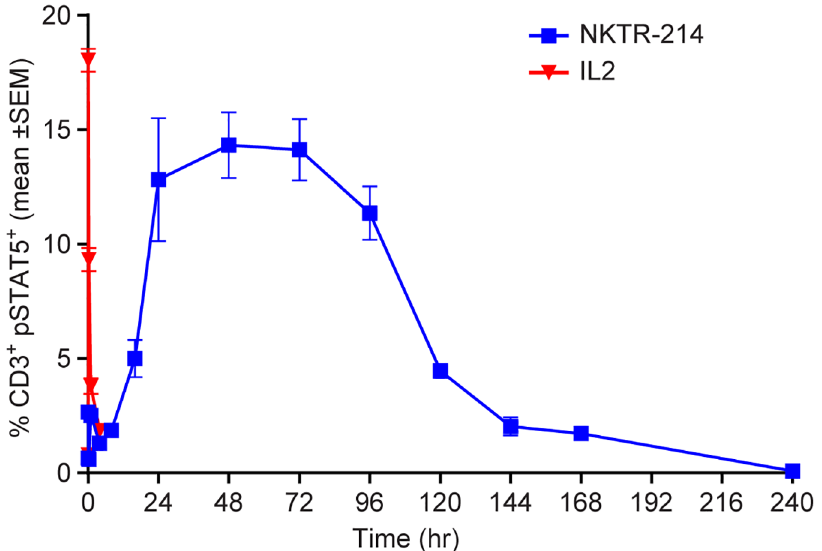
Fig 6. NKTR-214delivers a controlled and sustained activation signal to the IL2 pathway in vivo measuredby pSTAT5 levels in whole peripheral blood. Mice were treated with a single 0.8 mg/kg dose of either aldesleukin (red) or NKTR-214 (blue) and monitored for up to 240 hours. Peripheralblood was collected at the indicatedtime points post-doseand pSTAT5 in lymphocyte populations was determined by flow cytometry using antibodies to intracellularpSTAT5 and to extracellular surface marker CD3. N = 5 mice per time point per group.